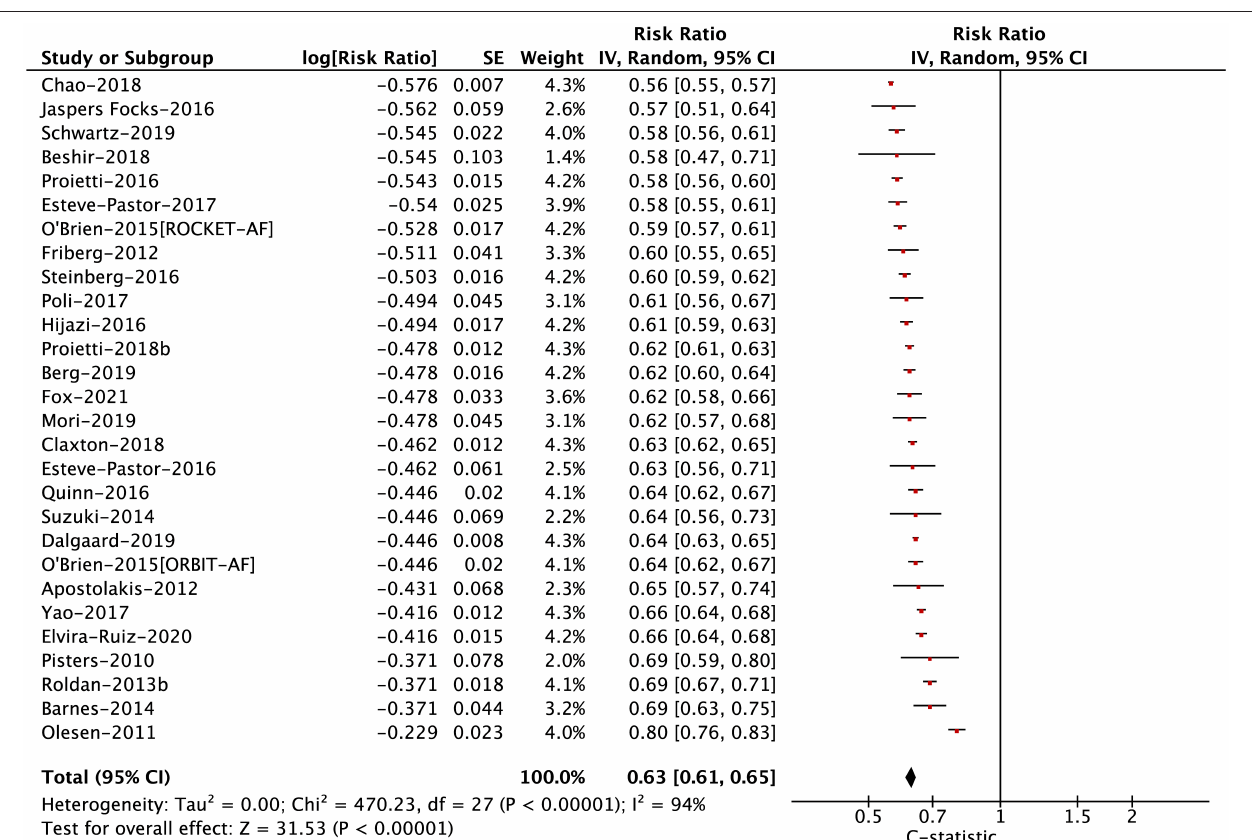
FIGURE 1 | The pooled analysis of the C-statistic for major bleeding in anticoagulated patients with atrial fibrillation.